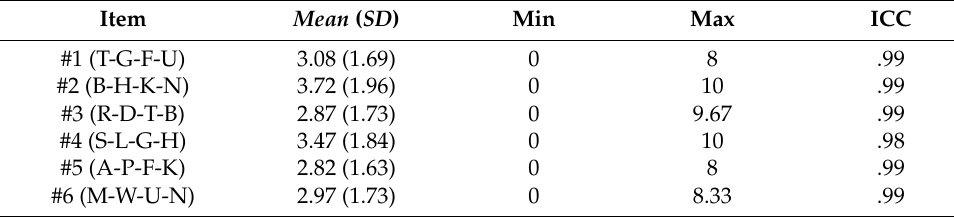
Table 2. Descriptive statistics for flexibility indicators, including